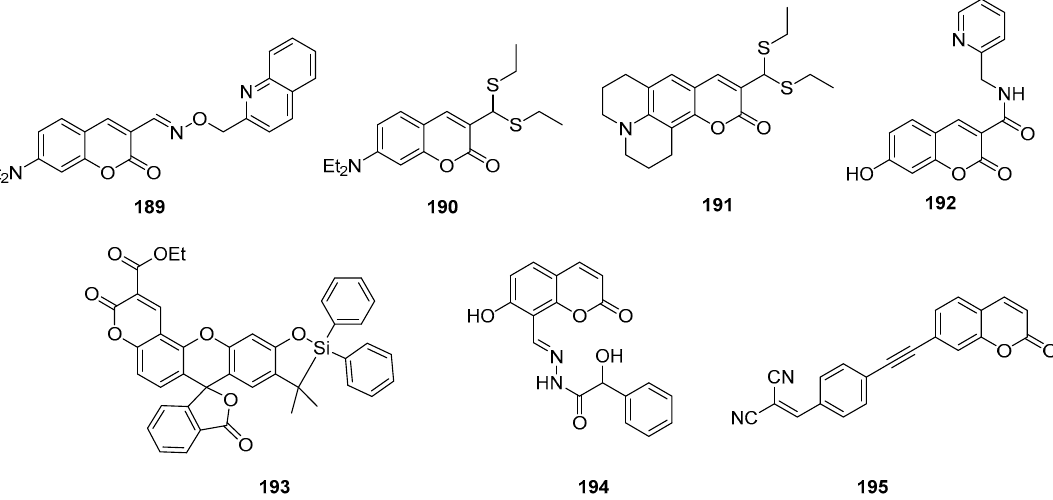
Figure 61. C hemical structure of different coumarin fluorescent probes for the detection of ions. Figure 61. Chemical structure of di ff erent coumarin fluorescent probes for the detection of